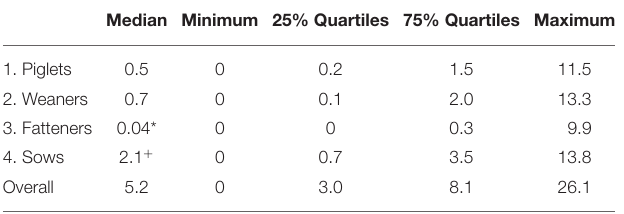
TABLE 3 | Median values, minimum, and maximum and 25%/75% quartiles of the number of defined daily doses Switzerland per pig (nDDDch/animal/year) measured on 71 farrow-to-finish farms in the year